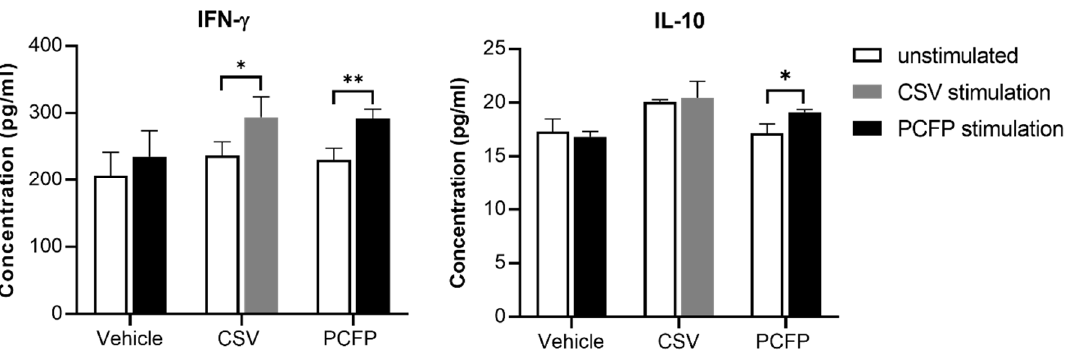
Figure 6. ELISA analysis of IFN- γ and IL-10 cytokines in the supernatant of ex vivo splenocyte cultures. Splenocytes isolated from immunized mice were cultured in the presence of CSV or PCFP for 72 h. The cytokine levels of IFN- γ and IL-10 was determined by ELISA. The data are shown as the mean ± SD, and were analyzed using Student’s t-test. * p < 0.05, ** p < 0.01.